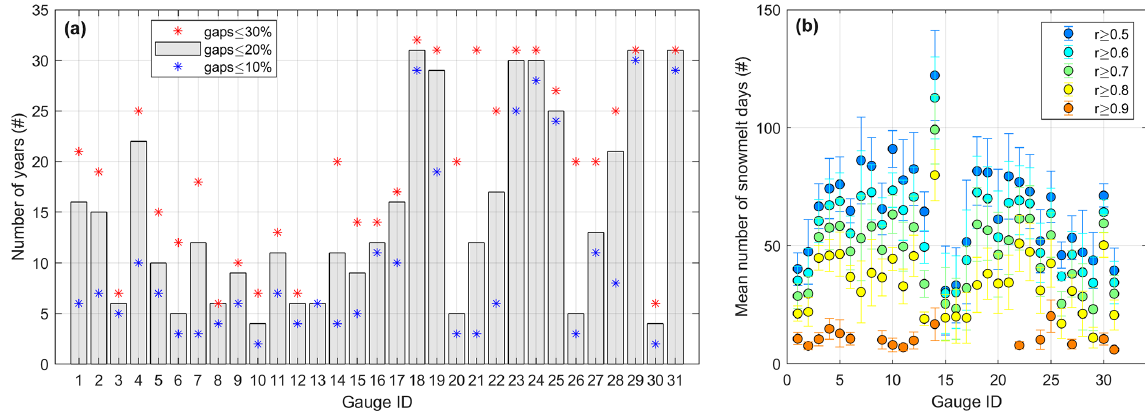
Figure A1. (a) Number of available years with less than 30%, 20%, and 10% gaps in days with hourly streamflow records between 1 December and 1 August. Gauge ID is as presented in Table 2. Numbers of years at site ID 13 are the same for all thresholds (overlapping symbols). (b) Sensitivity of the mean annual number of detected snowmelt days to different Spearman correlation cutoffs (0.5, 0.6, 0.7, and 0.9) between hourly solar radiation and streamflow. Error bar represents the standard